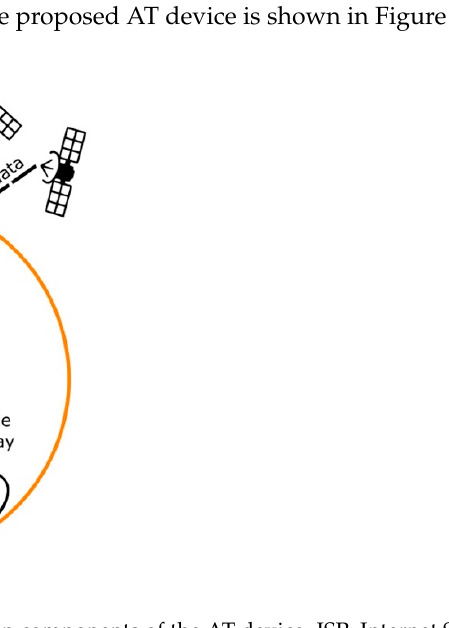
Figure 3. Overview of the AT device navigation software (mobile app). OSM: OpenStreetMap. GH: Graphhopper. Once the A-GPS coordinates have been acquired, they are plotted on the OSM map together with the user orientation signal coming from the smartphone’s digital compass. The user can then specify a destination or select it from a menu of previously saved des- tinations. When the destination is set, the app links to the Graphhopper API, which re- turns the route waypoints. The app processes these points and determines the naviga- tional instructions to the destination. The app no longer needs to communicate with the Graphhopper API unless a route recalculation is necessary. Instructions are then transmitted from the smartphone to the electronic module via Bluetooth. The electronic module consists of an embedded system with an ATMEL AT- tiny2313 microcontroller (Microchip Technology Inc., Chandler, AZ, USA) responsible for translating the instructions to actuator commands and for transmitting these latter to the tactile display. The app refreshes the A-GPS coordinates each 3 s or each 2 m (whatever happens first) and updates the user position in the OMS map accordingly. The app was carefully designed seeking to ensure accessibility. For users with rem- nant vision, the screen content can be magnified with the app’s built-in zooming features. For blind users, the app encompasses the Android’s TalkBack screen reader [41]. Natu- rally, the app can also be operated by a family member, caregiver, or friend.